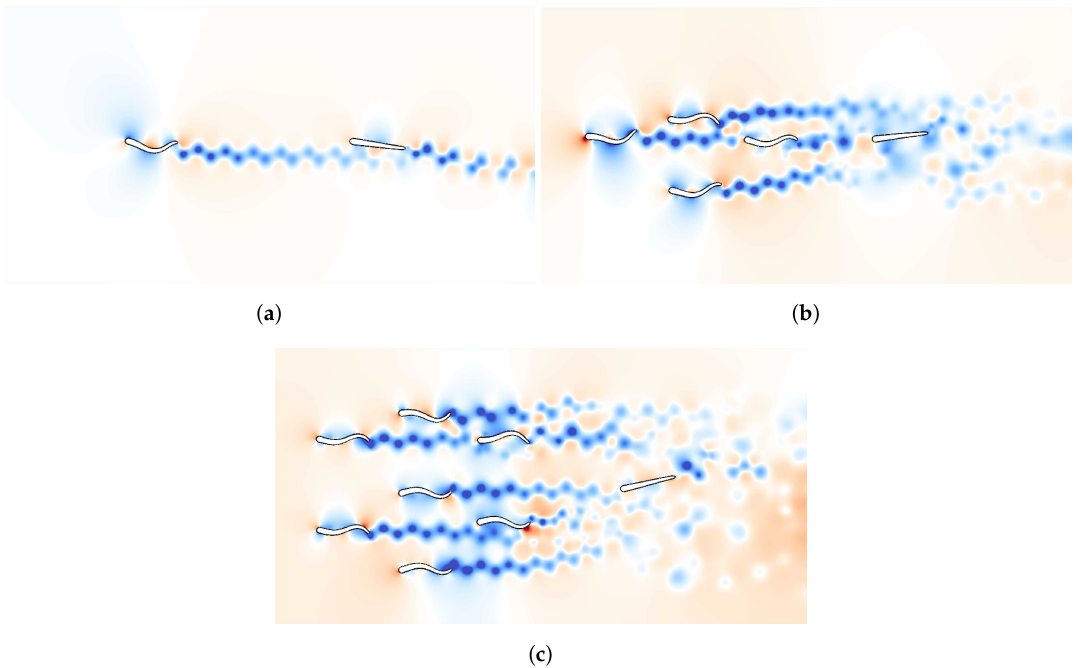
Figure 3. Snapshots of the pressure field in the environment of the follower swimmer generated by one ( a ), four ( b ) and seven ( c ) schooling swimmers. The snapshots are taken at the moment the measurement was performed for one particular location of the follower in the prior region. High pressure is shown in red and low pressure in